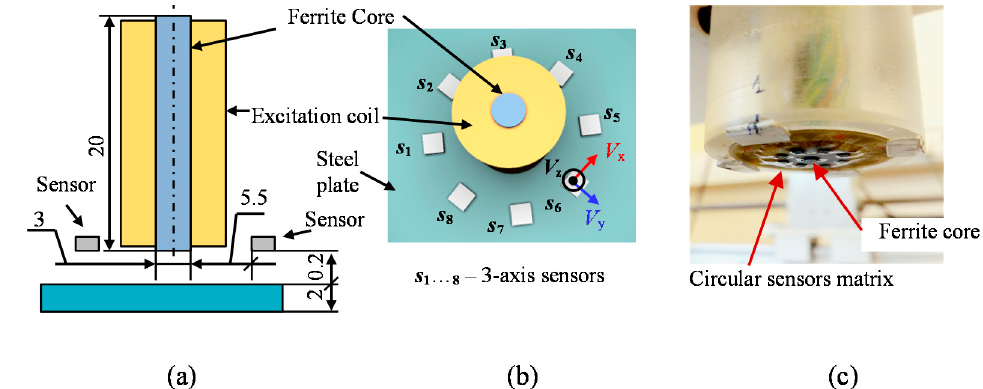
Figure 1. Model and photo of the multi-sensor transducer: ( a ) cross-section; ( b ) 3D view; ( c ) photo of the bottom-side, all dimensions are in [mm].